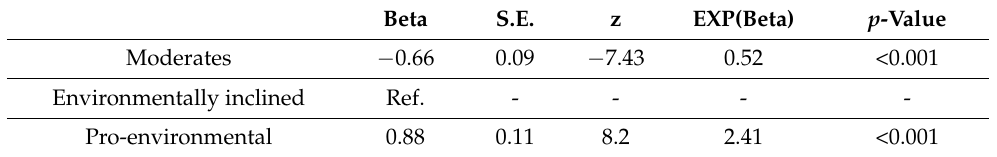
Table A1. Logistic regression model: 1-retaining status quo ~ class membership (income adjusted).